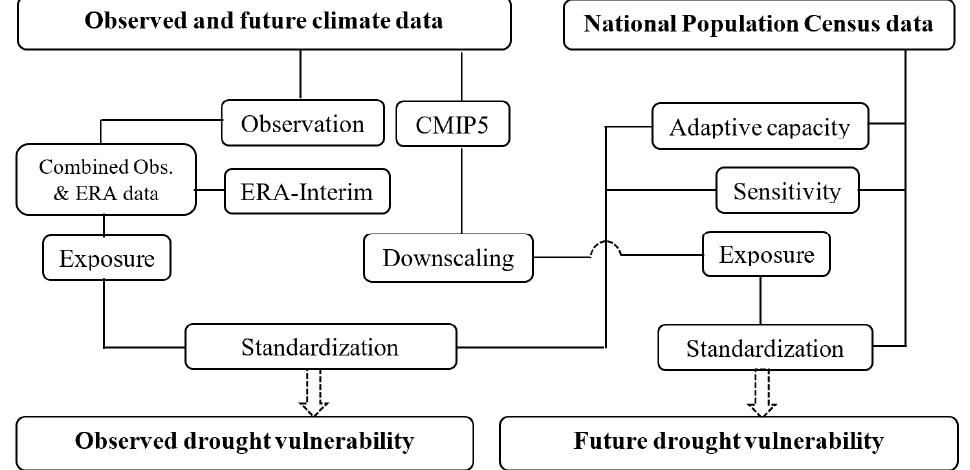
Figure 1. Overview of research design.